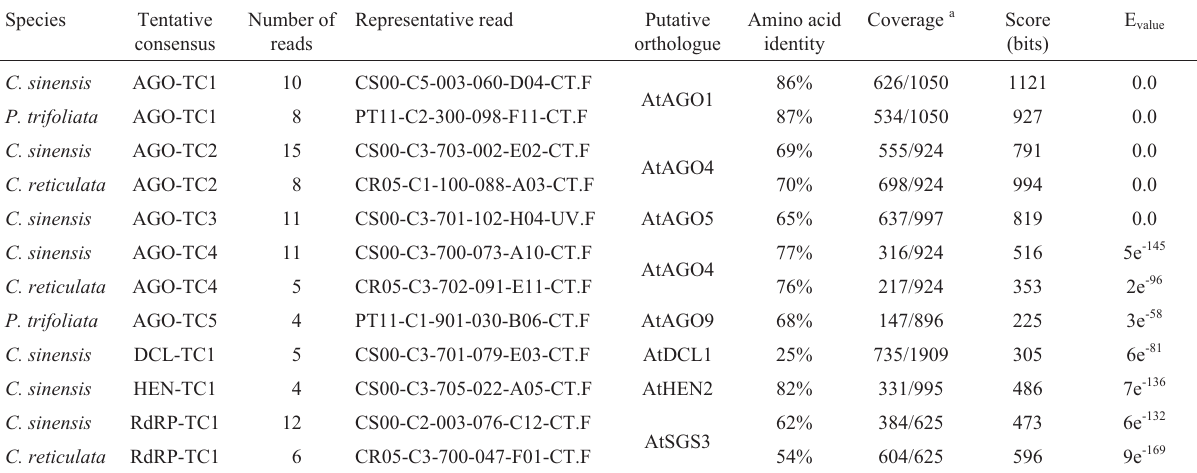
Table 3 - Similarity of citrus tentative consensus with Arabidopsis genes involved in PTGS pathways in each species. Only TCs with more than four reads per species were included.